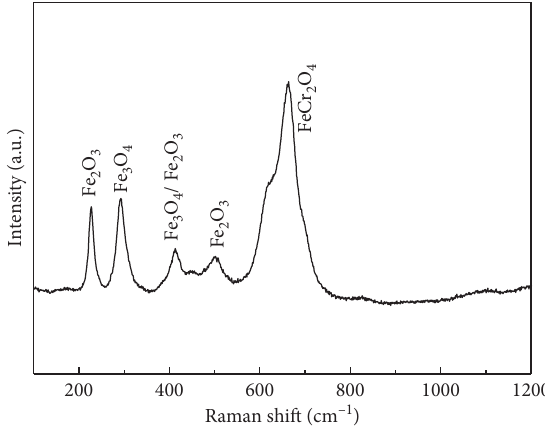
° C with 2 SO 4 at 75